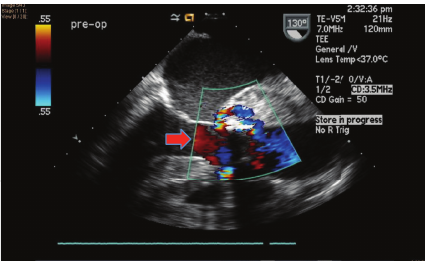
Figure 3: Transesophageal echocardiogram in long axis view with color flow Doppler showing severe paravalvular aortic regurgitation (indicatedbyredarrow),aroundabioprostheticaorticvalve,around which an extensive aortic root abscess has